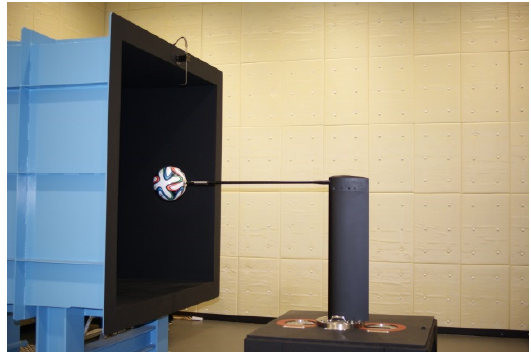
Figure 2. Set up of wind tunnel experiment.